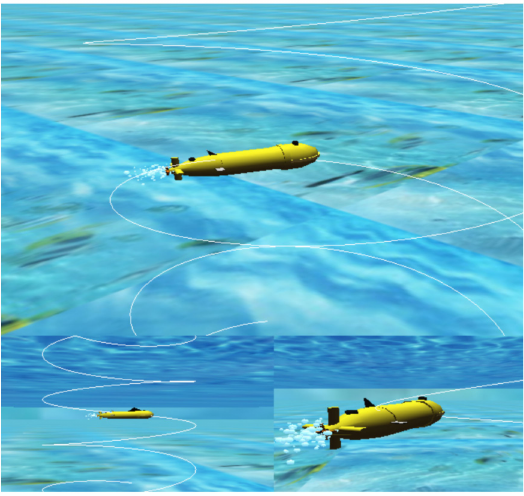
Figure 10. 3D underwater virtual scene in